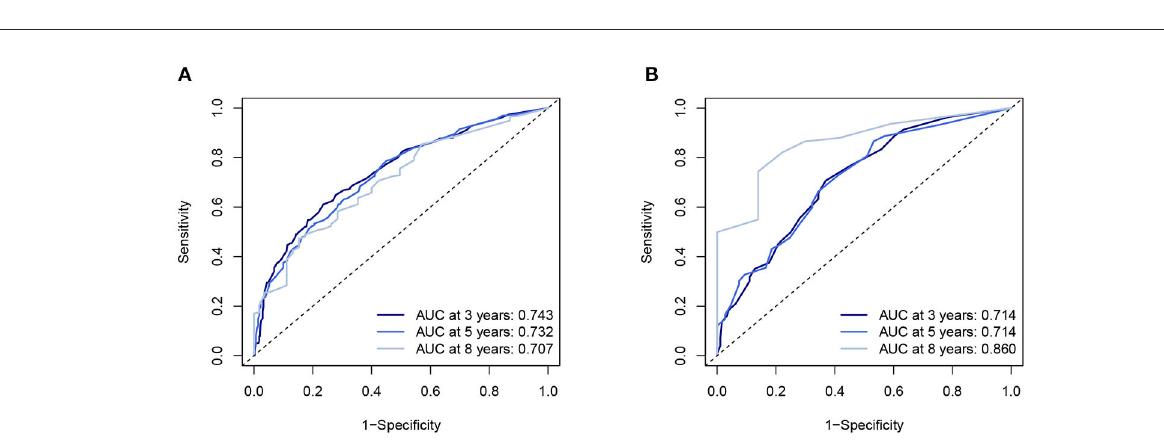
FIGURE3 The AUC of nomogram of 3-, 5-, and 8-year in the training set (A) and validation set (B) . AUC, Receiver operating